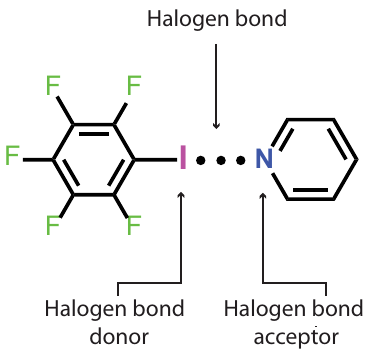
Fig. 1 | Halogen bond. General representation of a halogen-bonded complex depicting an I···N